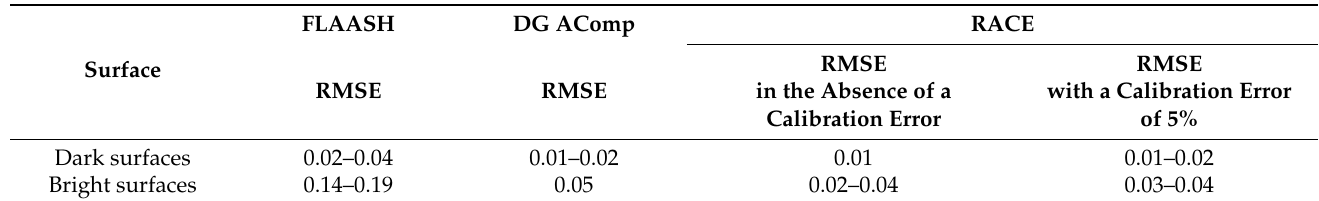
Table 14. Comparison of the accuracy of surface reflectance retrieval by different algorithms.